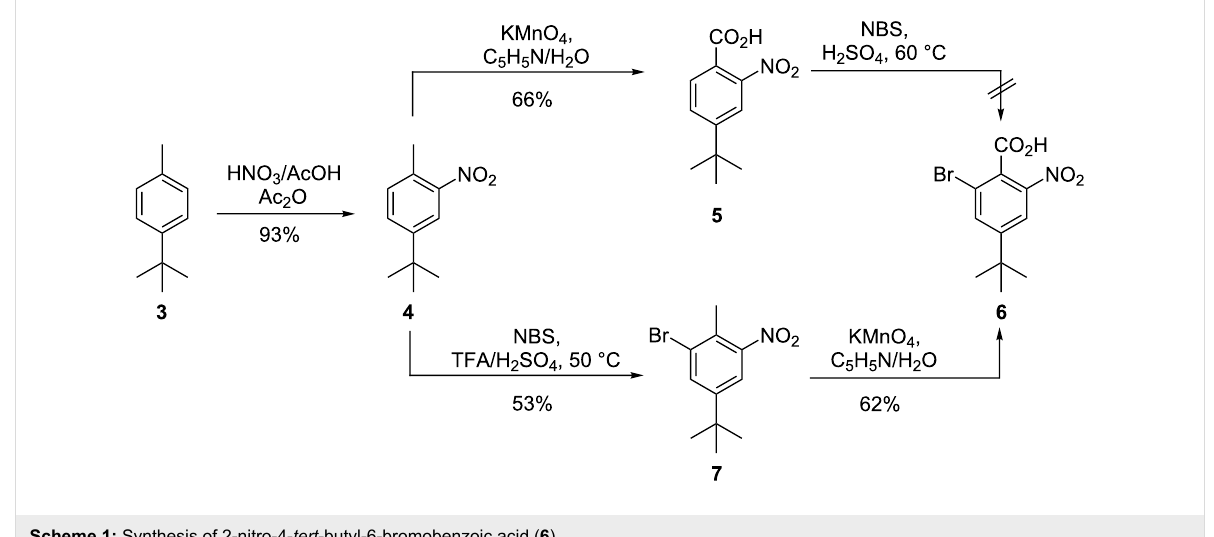
Scheme 1: Synthesis of 2-nitro-4- tert -butyl-6-bromobenzoic acid ( 6 ).